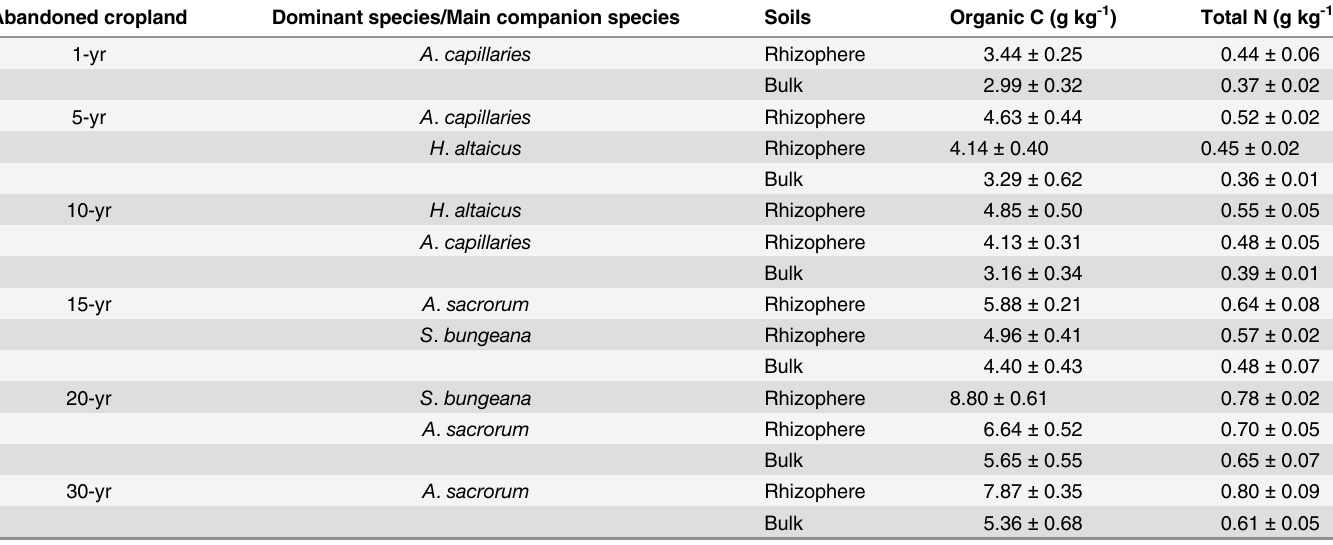
Table 2. Change of soil organic C and total N during the natural succession